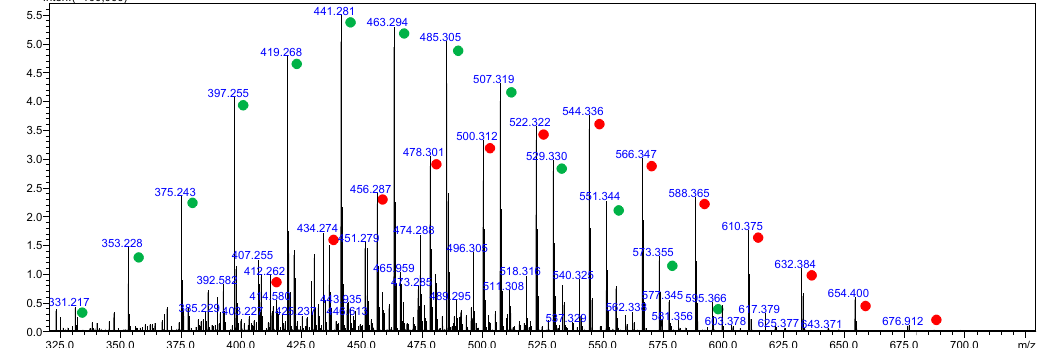
Figure 5. LCMS chromatogram of cosmetic hair product. Top panel: gray line indicates total ion current (TIC), whereas green line (A) represents extracted ion chromatogram (XIC) for laureth betaine [M] + m / z = 272.252, red line (B) represents XIC for laureth sulfosuccinate [M − H] − m / z = 365.163. Mass spectra corresponding to the indicated peaks are shown in the panels. LC-ESI-MS system (Shimadzu LC-IT-TOF) was used.